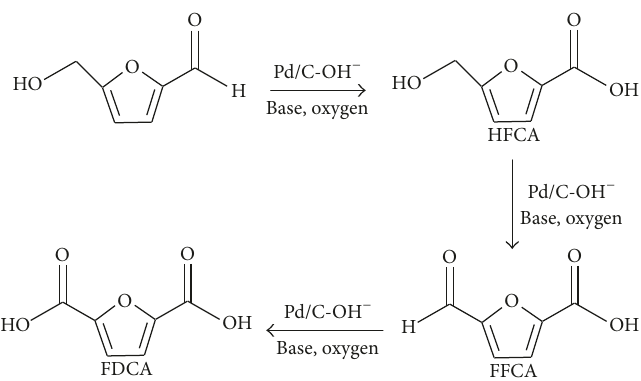
Scheme 1: Reaction of HMF oxidation to